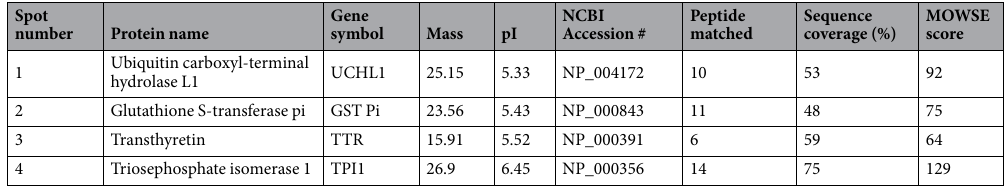
Table1. Identification of candidate proteins by